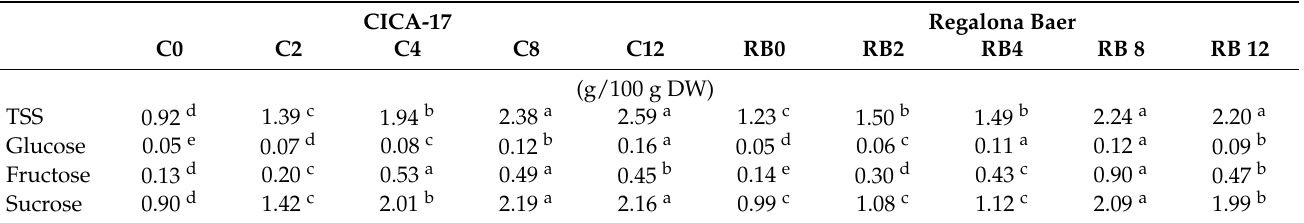
Table 3. Total soluble sugar, glucose, fructose, and sucrose contents in the seeds of CICA-17 and Regalona Baer varieties under different goat manure dose treatments.